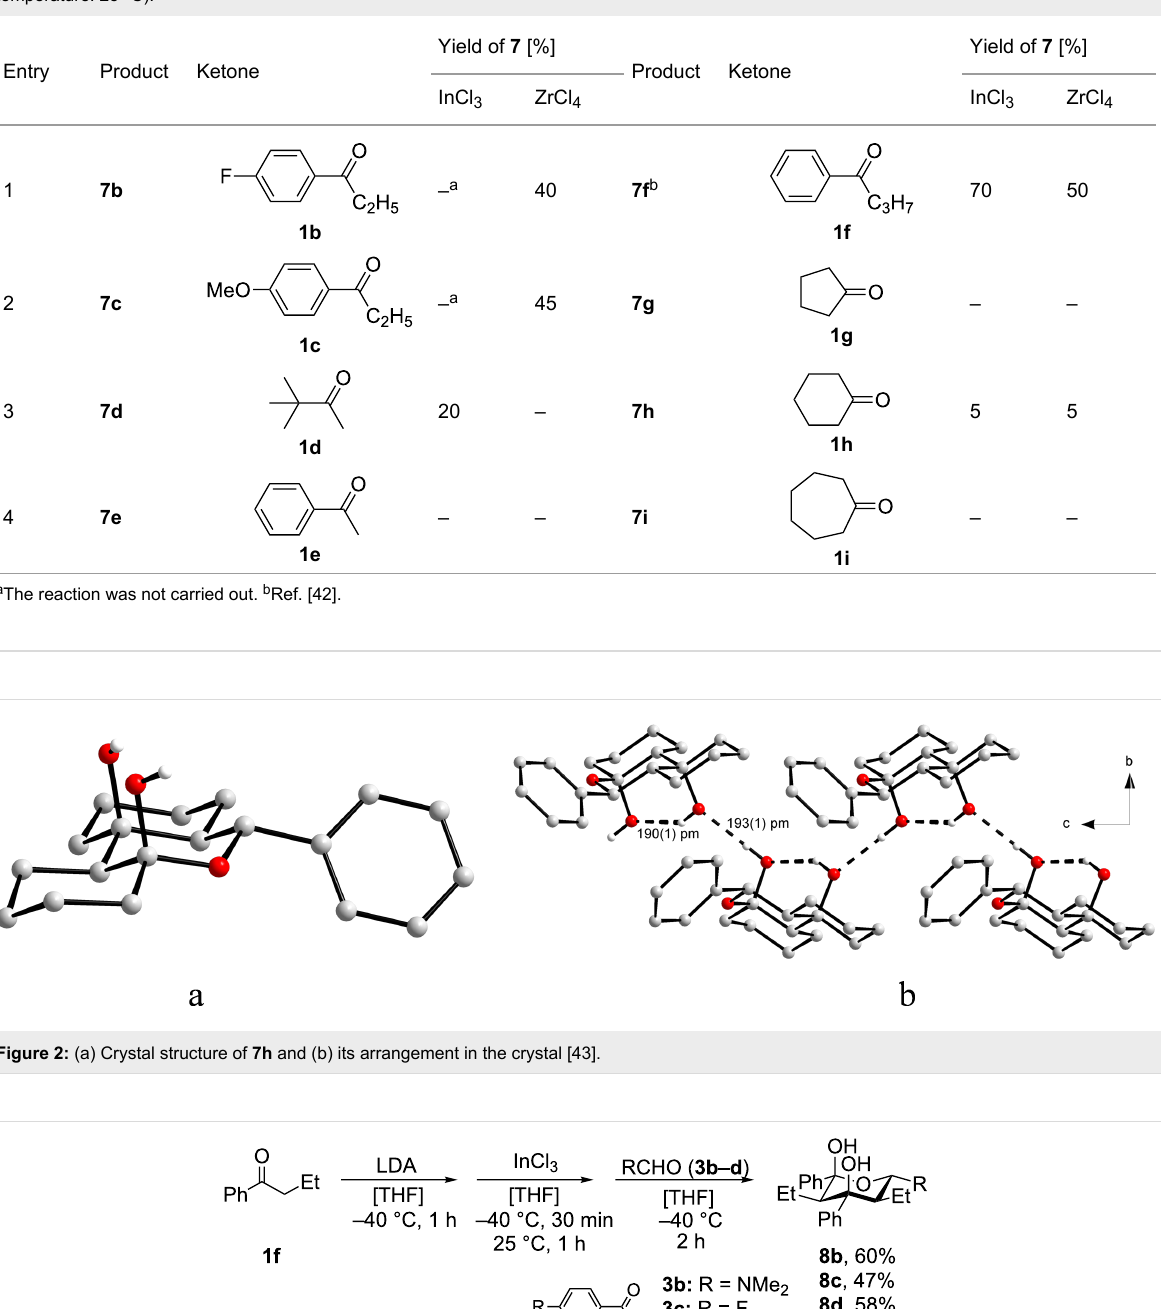
Table 6: Variation of the ketone in the domino aldol reaction with benzaldehyde ( 3a ) in the presence of InCl 3 and ZrCl 4 (reaction time: 2 h, reaction temperature: 25 °C).